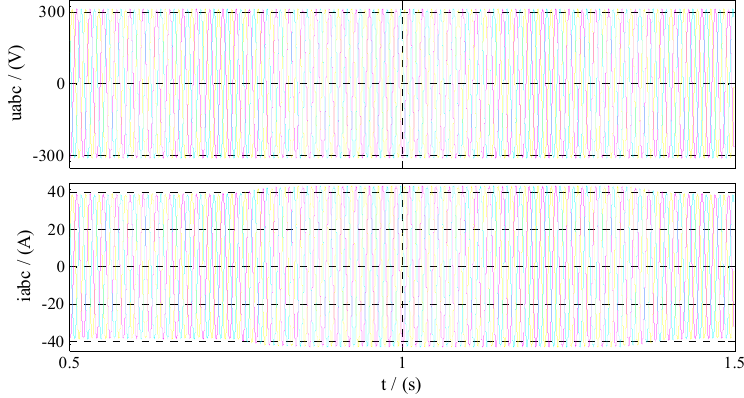
Figure A4. System output voltage and current when the frequency decreases by 0.3 Hz.